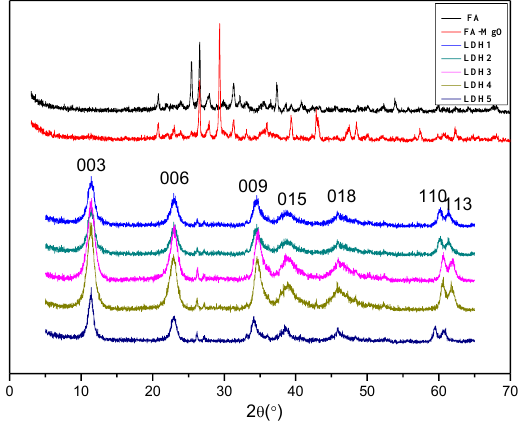
Figure 1. XRD pattern of samples. Table 1. Structural parameters of Mg-Al-Fe LDHs.